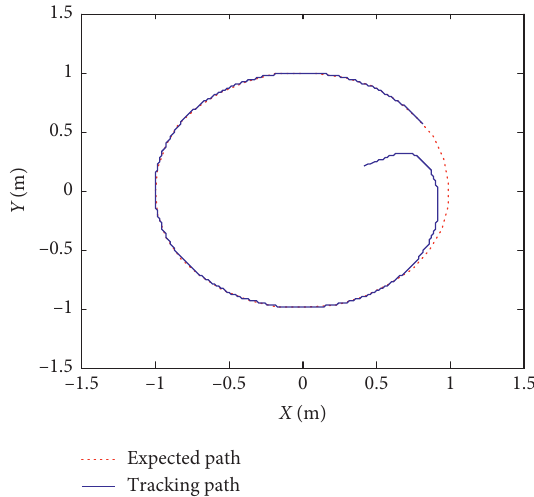
Figure 2: Expected path and tracking